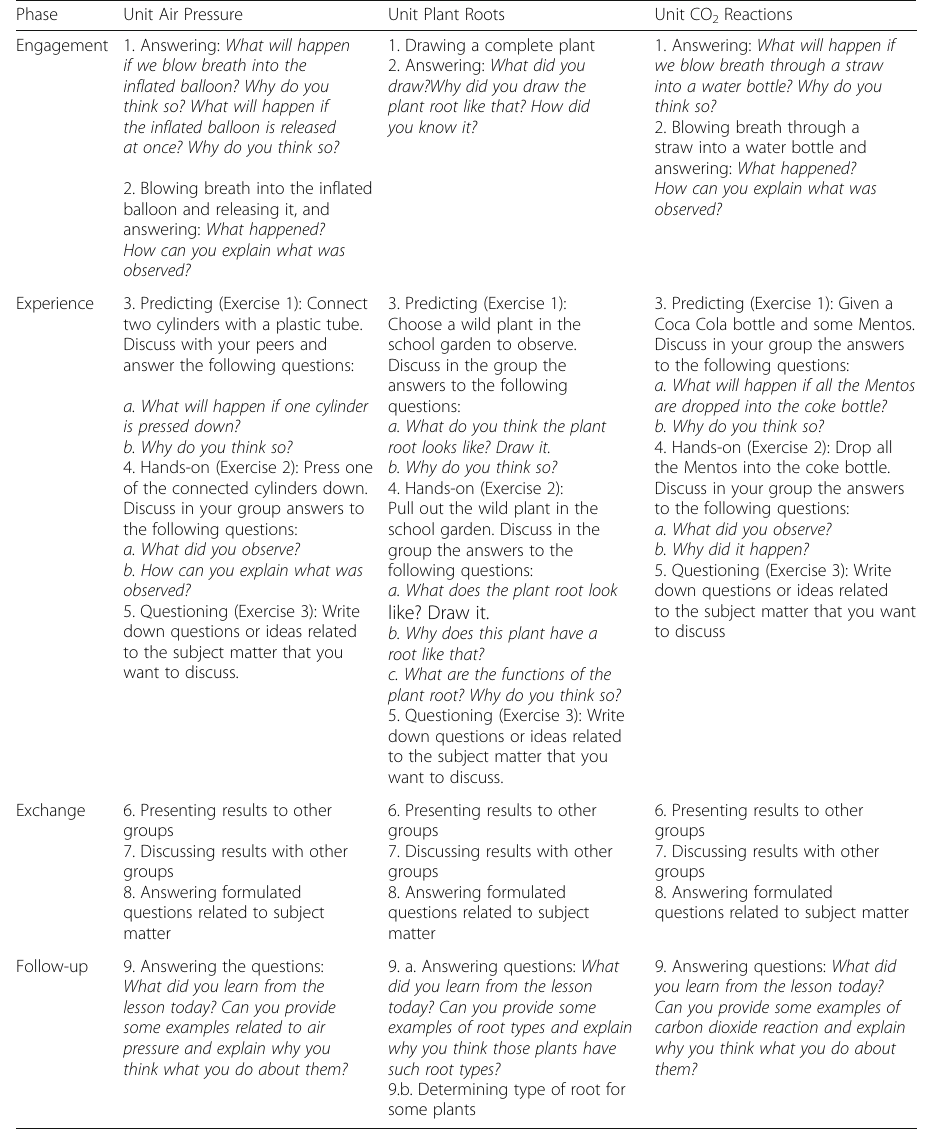
Table 7 The designs of exemplary curriculum units Phase Unit Air Pressure Unit Plant Roots Unit CO 2